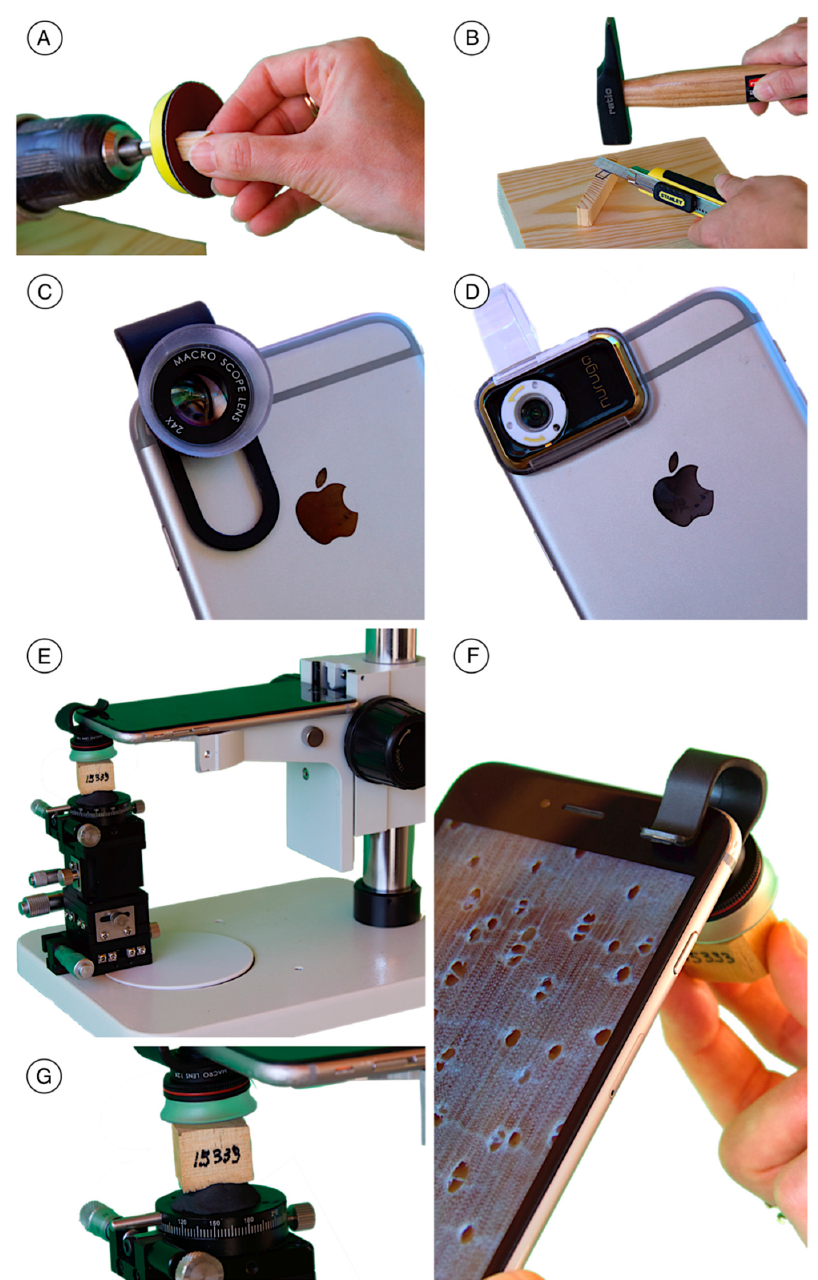
Figure 1. Preparation, lenses and support. ( A ) Portable sander with 50 mm discs. ( B ) Obtaining tangential and radial sections by splitting the wood. ( C ) VicTsing macro scope 24× lens. ( D ) Nurugo 400× lens. ( E ) Support and 10 mm precision micrometric platform for observation with 400× lens. ( F ) Observation with no support using 24× lens. ( G ) Sample held in place with plasticine to ensure it remains parallel to the lens.